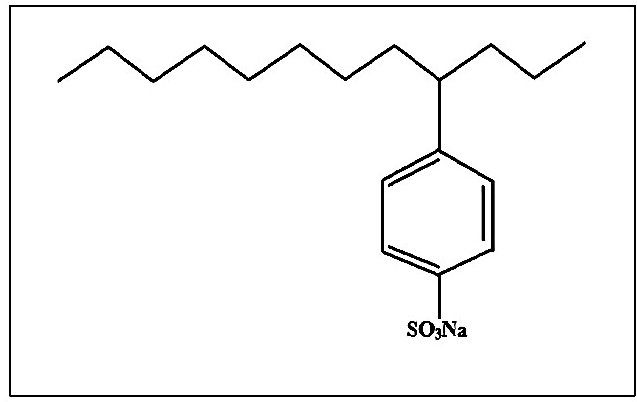
Figure 1. The chemical structure of surfactant-sodium dodecylbenzene sulfonate (SDBS) [8].